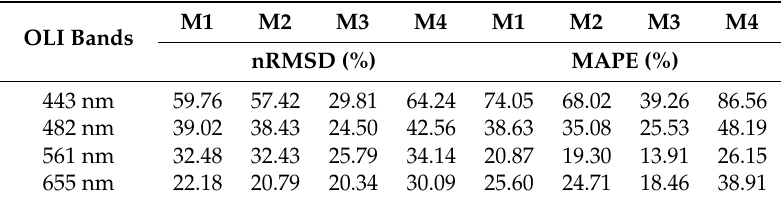
Table 6. Error assessment (nRMSD) from comparisons between in situ R rs (retrieved from glint removal corrections—M1, M2, M3, M4) and simulated R rs . NRMSD (Normalized Root Mean Squared Difference, in %) and MAPE (Mean Absolute Percentage Error (in %) resulted from simulated R rs and M1, M2, M3, and M4 comparisons for the entire spectrum.